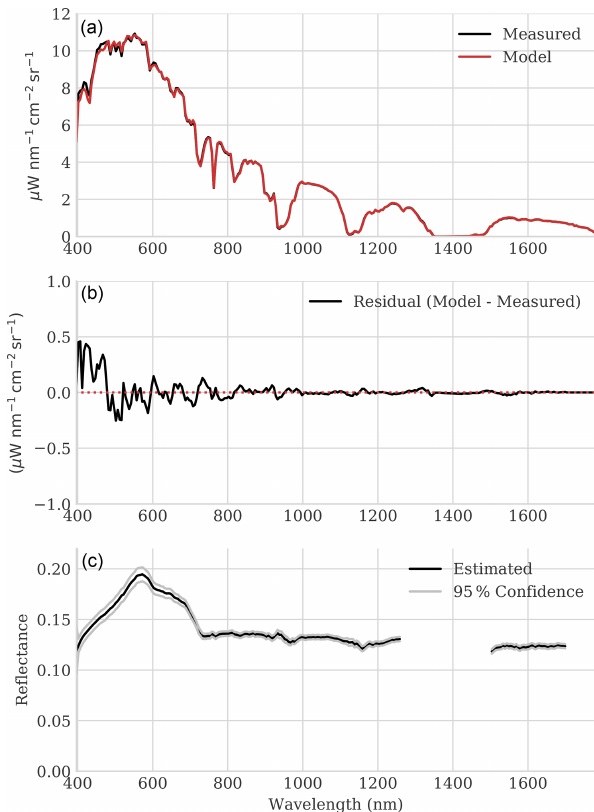
Figure 7. (a) Example radiance spectrum. (b) Model fit residual. (c) Estimated reflectance with 95% confidence